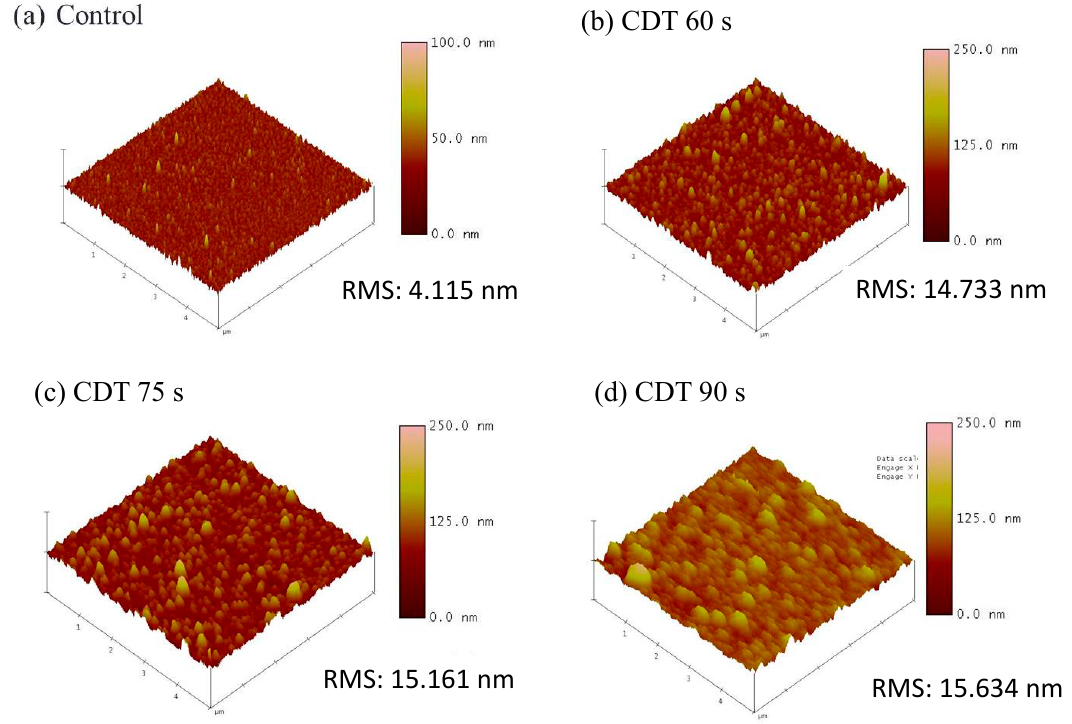
Figure 3. Atomic force microscopy (AFM) images of Cu surface morphology of the ( a ) control; ( b ) CDT 60 s; ( c ) CDT 75 s; and ( d ) CDT 90 s samples.